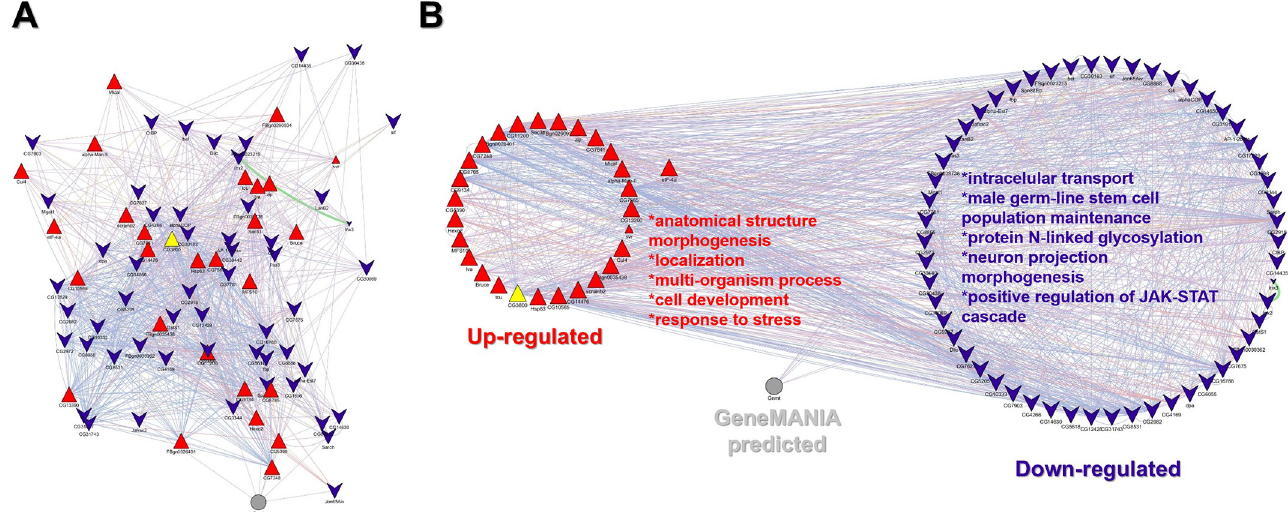
Fig 7. Thrombospondin gene interacting network. A) Topology of the hub thrombospondin (yellow triangle) network with its first up and down -regulated gene neighbors. B) Circular interacting gene network, thrombospondin is in the unregulated group. In both networks, functional enriched up-regulated transcripts are in red triangles, down-regulated transcripts are in blue chevrons, the gray circle represents a set of non-immunological related genes predicted by a GeneMANIA.